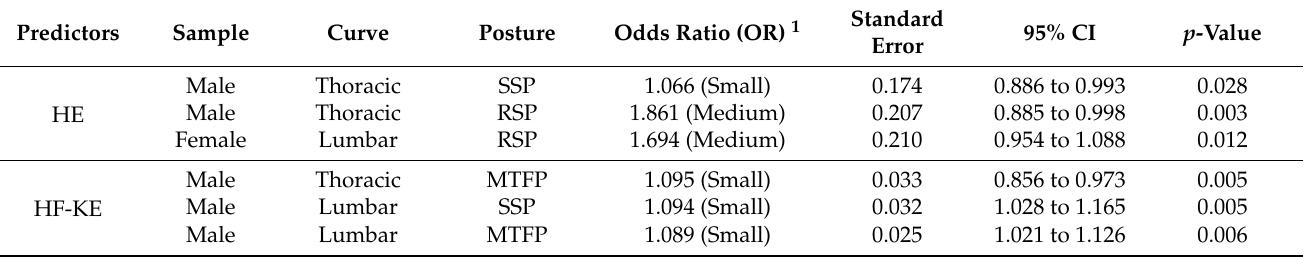
Table 3. Hip range of motion as predictive of sagittal spine misalignments in male and female